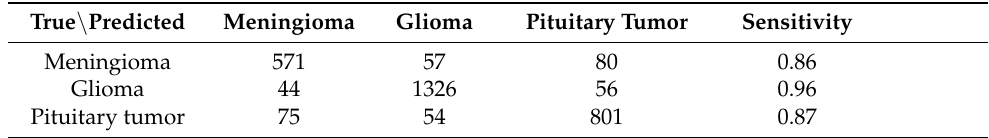
Table 2. Confusion matrix of the predicted tumor for Cheng et al. [5] method. The tumor type precision (tumor classification accuracy) achieved ( ∑ diag/ ∑ total) is 0.912.